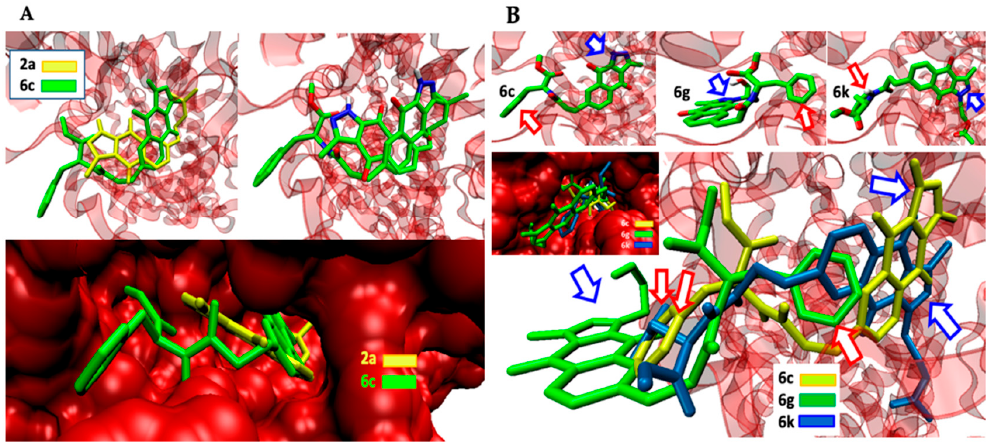
Figure 4. ( A ): Comparative arrangement of simple ( 2a ) and conjugated ( 6c ) BIZQs docked in COX-2. ( B ) Independent and simultaneous docking of BIZQs 6c , 6g , and 6k conjugated with Phe. Blue and red arrows point to the pyrazole ring of each BIZQ and to the phenyl group of each Phe, respectively.